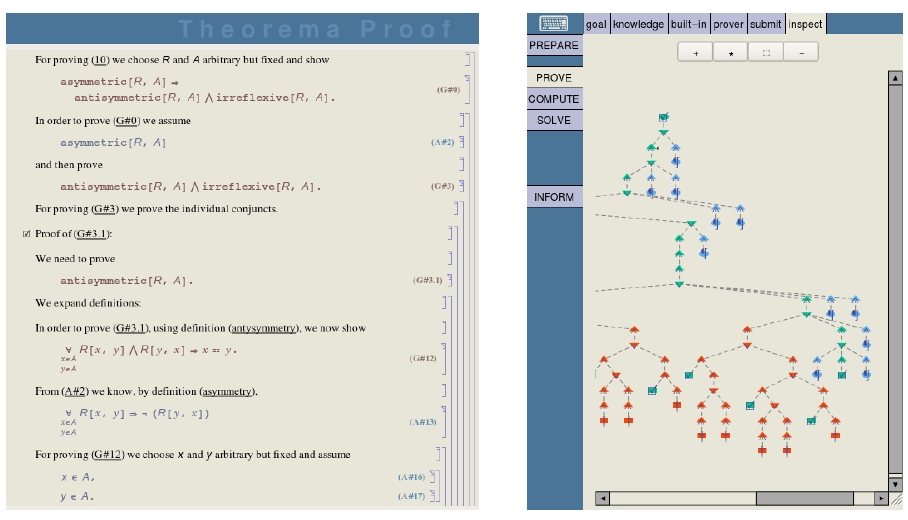
Fig. 4. The natural language proof presentation (left) and the corresponding proof tree (right) 2.2 Software Technological Aspects of Theorema